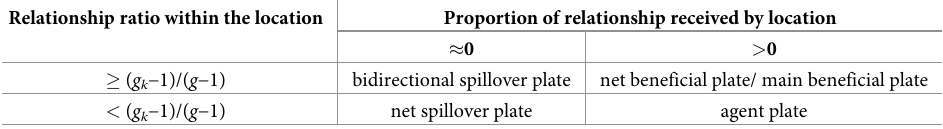
Table 2. Four position types in block